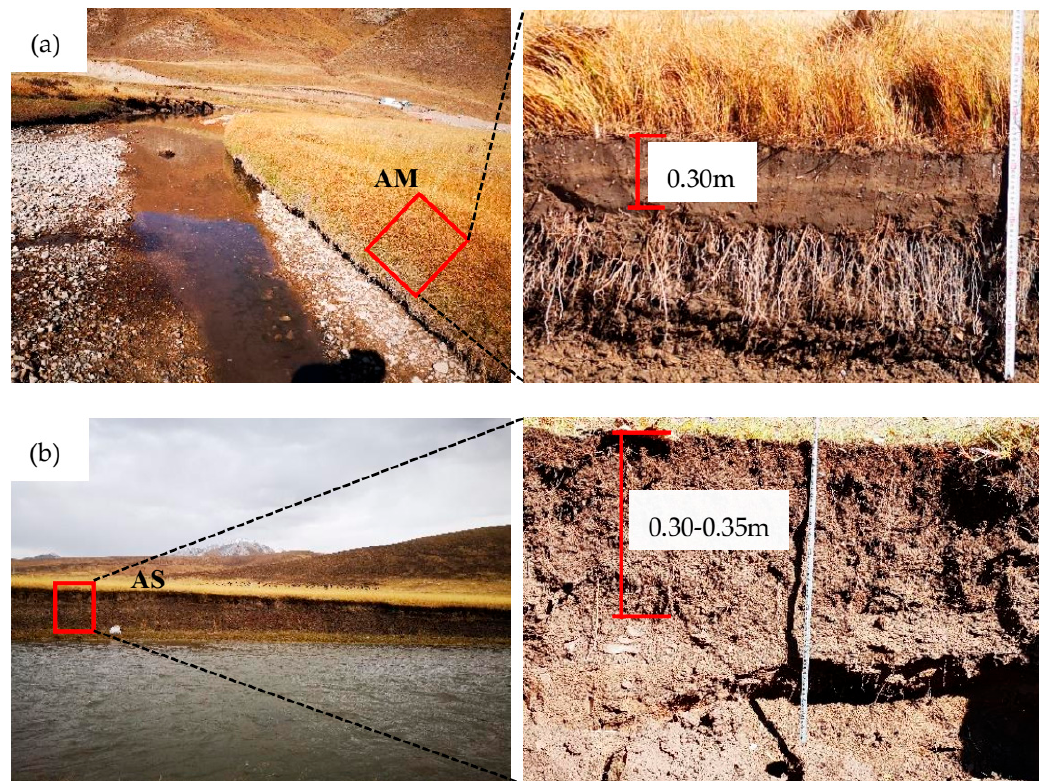
Figure 2. Riverbanks and their vertical profiles at ( a ) site 1, which is covered by AS, and ( b ) site 2, which is covered by AM (not to scale).